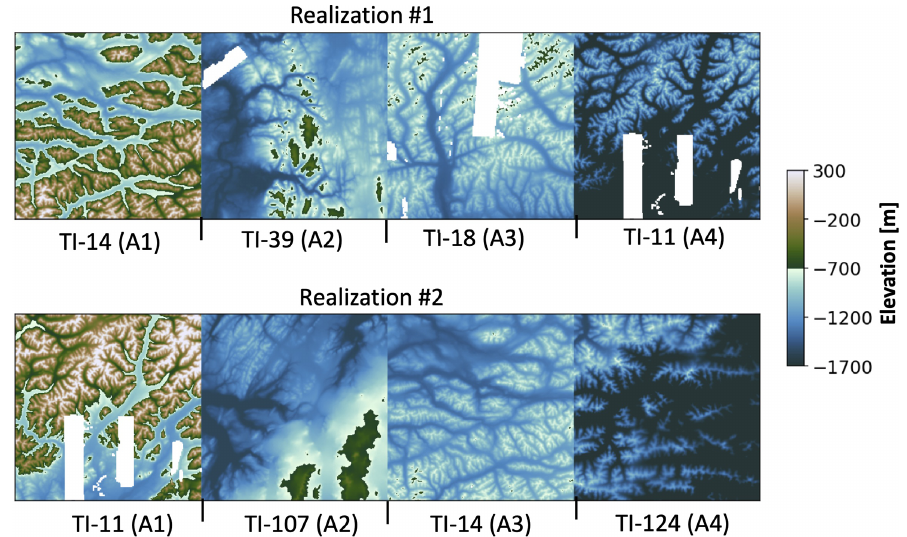
Figure 11. Examples of sampled TIs from the posterior distributions corresponding to the subarea (A1, A2, A3, A4). The TIs are rescaled back to the local radar data range by inverting the min–max